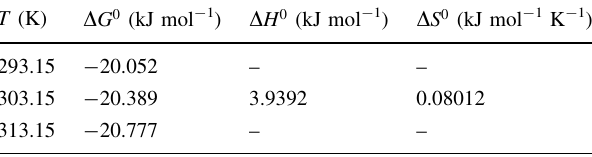
Table 3 Thermodynamic parameters for the adsorption of